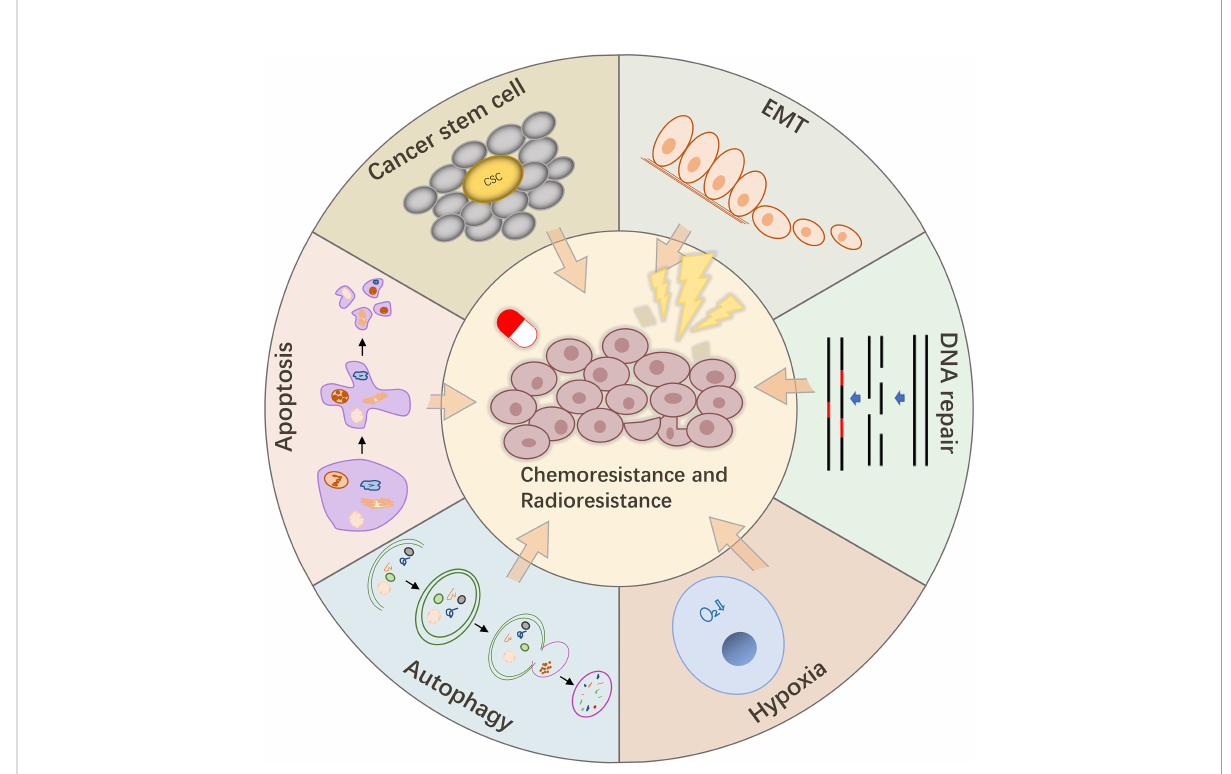
FIGURE 3 LncPVT1 regulates chemoresistance and radioresistance through autophagy, apoptosis, EMT, CSC, DNA damage repair, hypoxia, and other